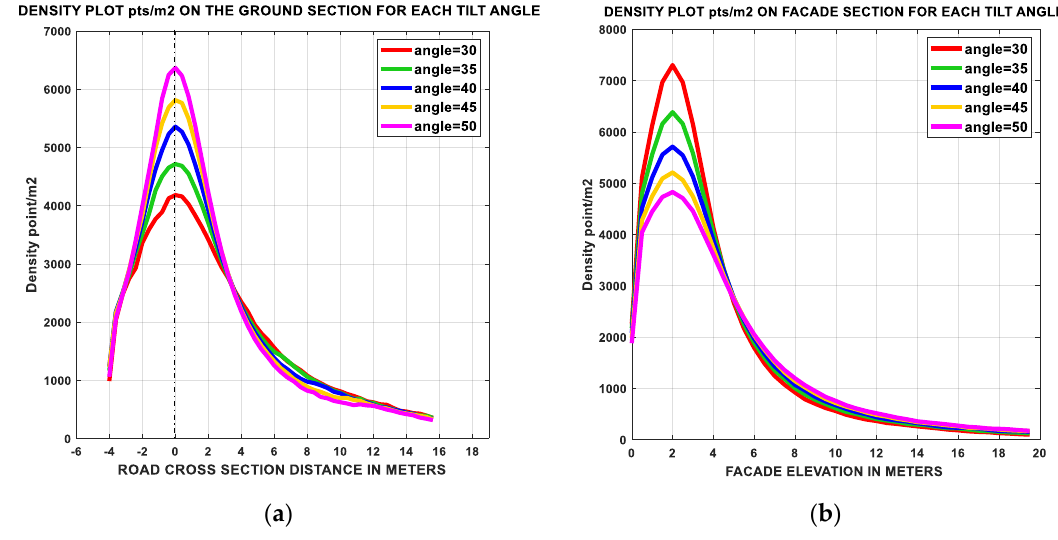
Figure 21. OS-1-64 density checks on selected point clouds slices. ( a ) Density computed on the ground section. ( b ) Density computed on the 5 m distant facade section.